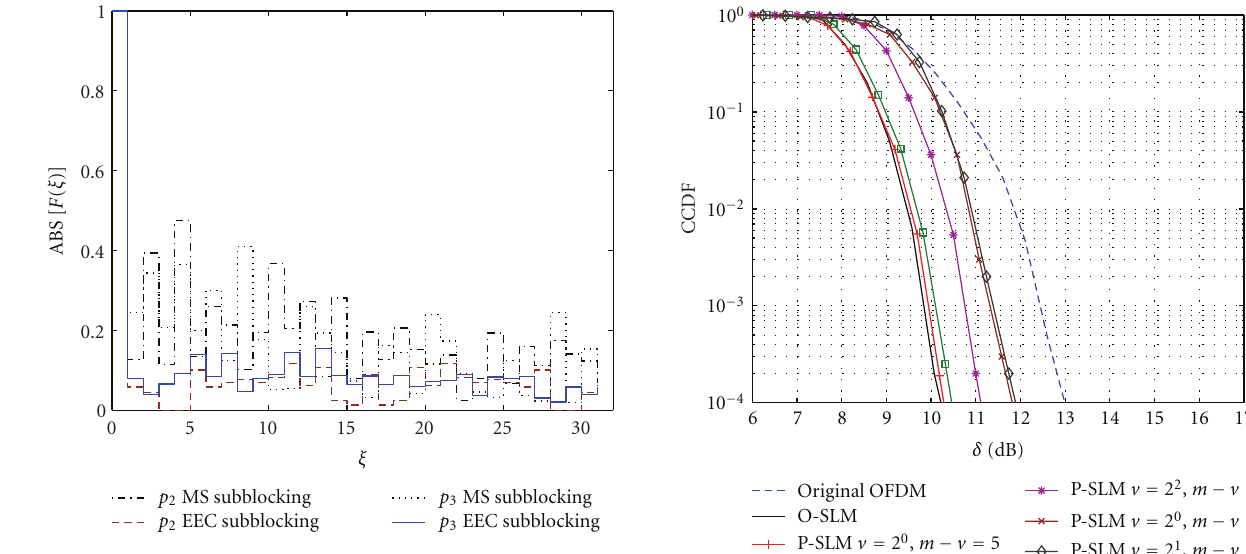
Figure 15: Autocorrelation of the PTS sequences for N = 32, v = 3, P = 4, r = 2, with m -sequence and ECC subblocks, p